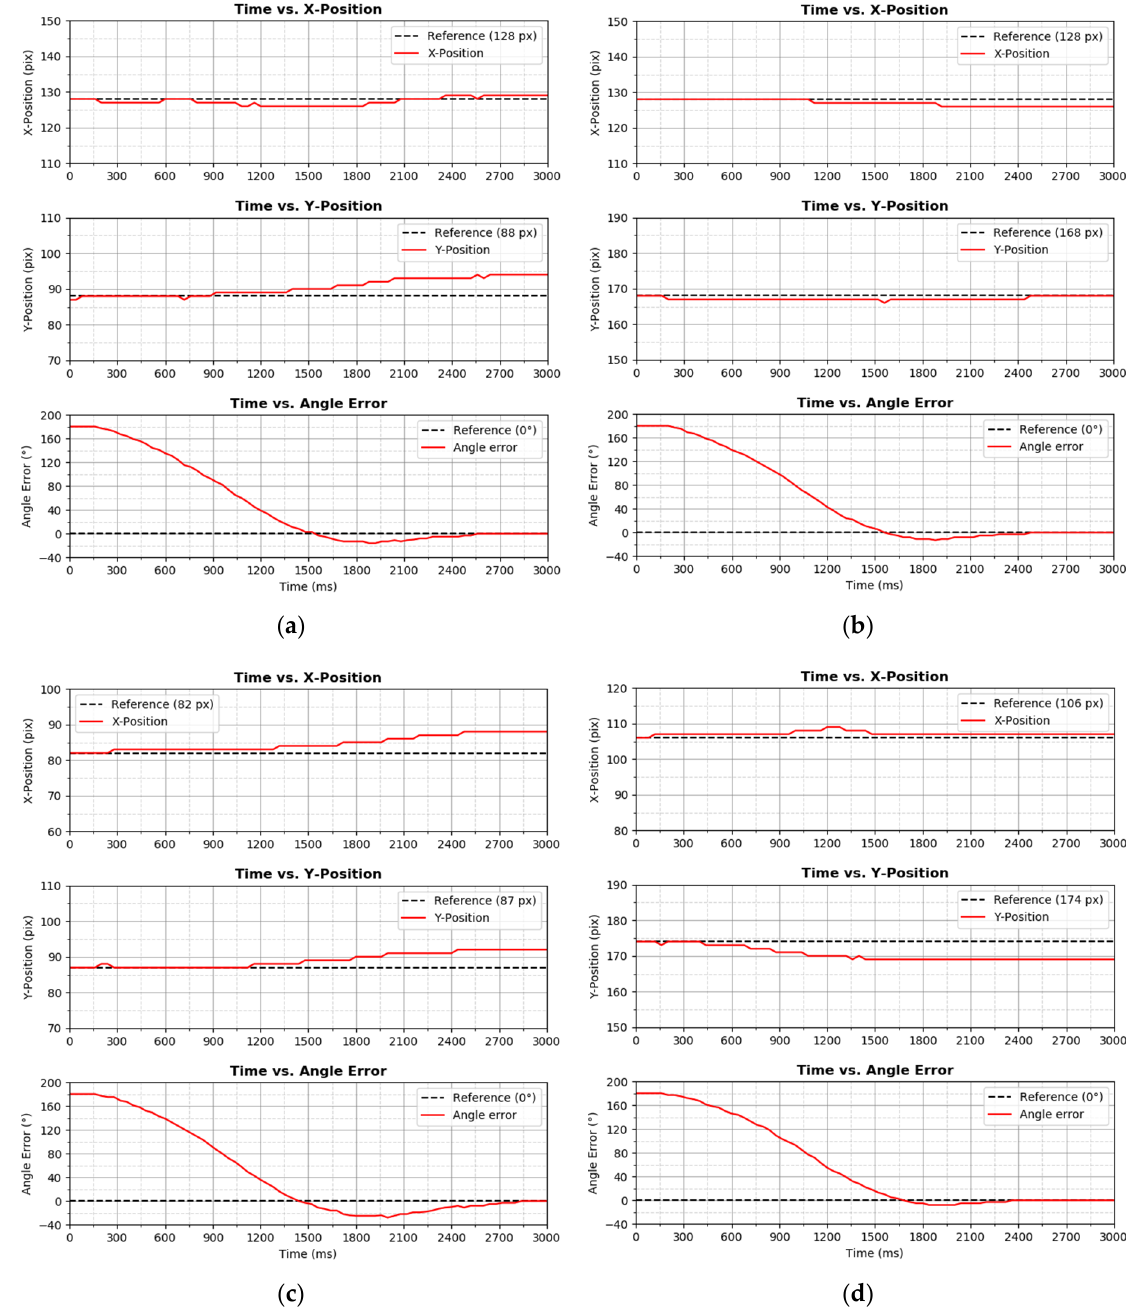
Figure 13. Closed-loop orientation control with PD–PD controller and with step reference input value of 180° at starting locations ( a ) (128 px, 88 px), ( b ) (128 px, 168 px), ( c ) (82 px, 87 px), and ( d ) (106 px, 174 px). The controls of X-Position and Y-Position are in open-loop, without any controller.